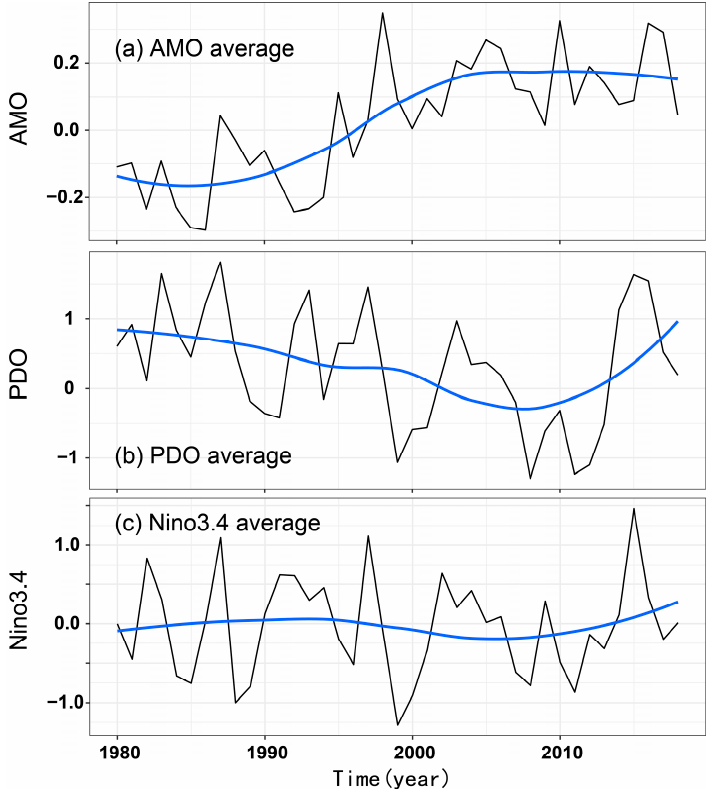
Figure 1. Spatial characteristics of annual SPEI, LHF and soil moisture.